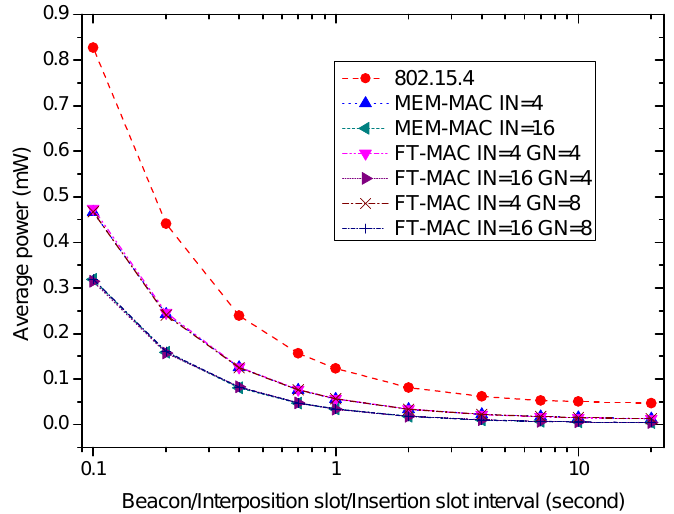
Figure 17. The effect of the beacon/interposition/insertion intervals on node average